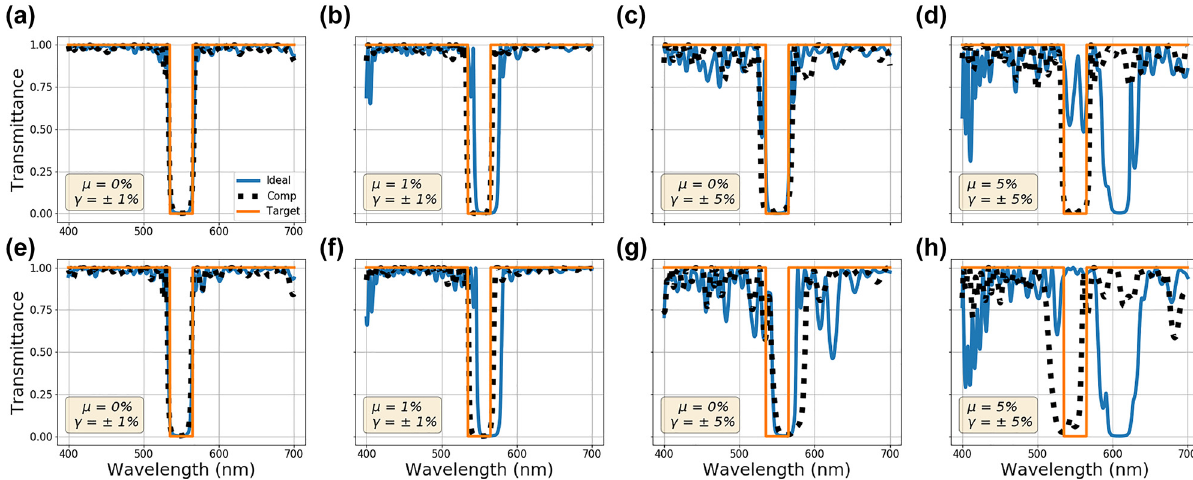
Figure 9: Multilayer stack optimization in the presence of random fabrication imperfections. Results after random error is added for both ideally optimized stacks (blue solid line) and stacks optimized considering random imperfections during the optimization process (black dotted line). The orange solid line is the target spectra. The transmittance of the multilayer stacks produced by both methods is tested with 1000 different sets random imperfections. The transmittance curves for the highest and the lowest performing stacks from their respective sets of results are shown in the top (a)–(d) and bottom (e)–(h) rows, respectively. The mean and the range of the uniform distribution used to create random imperfections are (a and e) 𝜇 = 0% and 𝛾 = ± 1%, (b) and (f) 𝜇 = 1% and 𝛾 = ± 1%, (c) and (g) 𝜇 = 0% and 𝛾 = ± 5%, and (d and h) 𝜇 = 5% and 𝛾 = ± 5%, respectively.